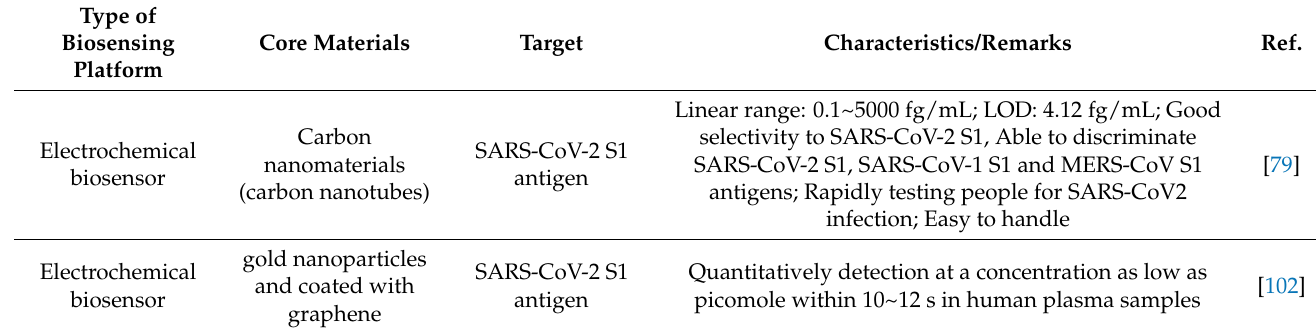
Table 7. Comparisons and characteristics of different biosensors for human respiratory diseases diagnosis (taking COVID-19 as an